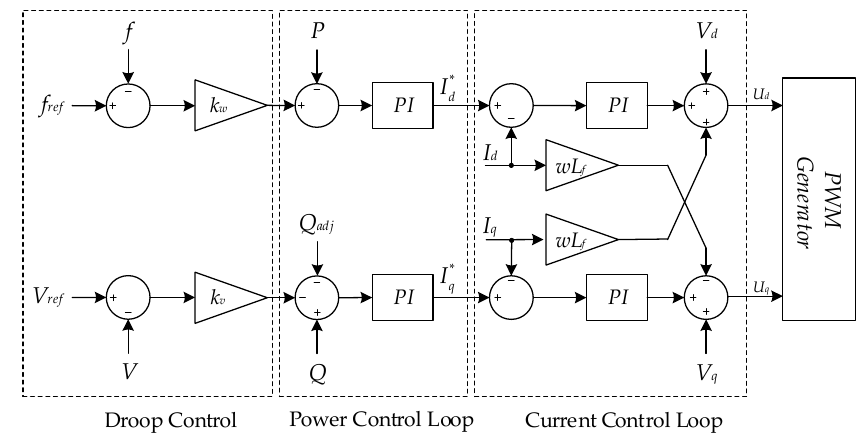
Figure 4. Control diagram of power and current control loops.